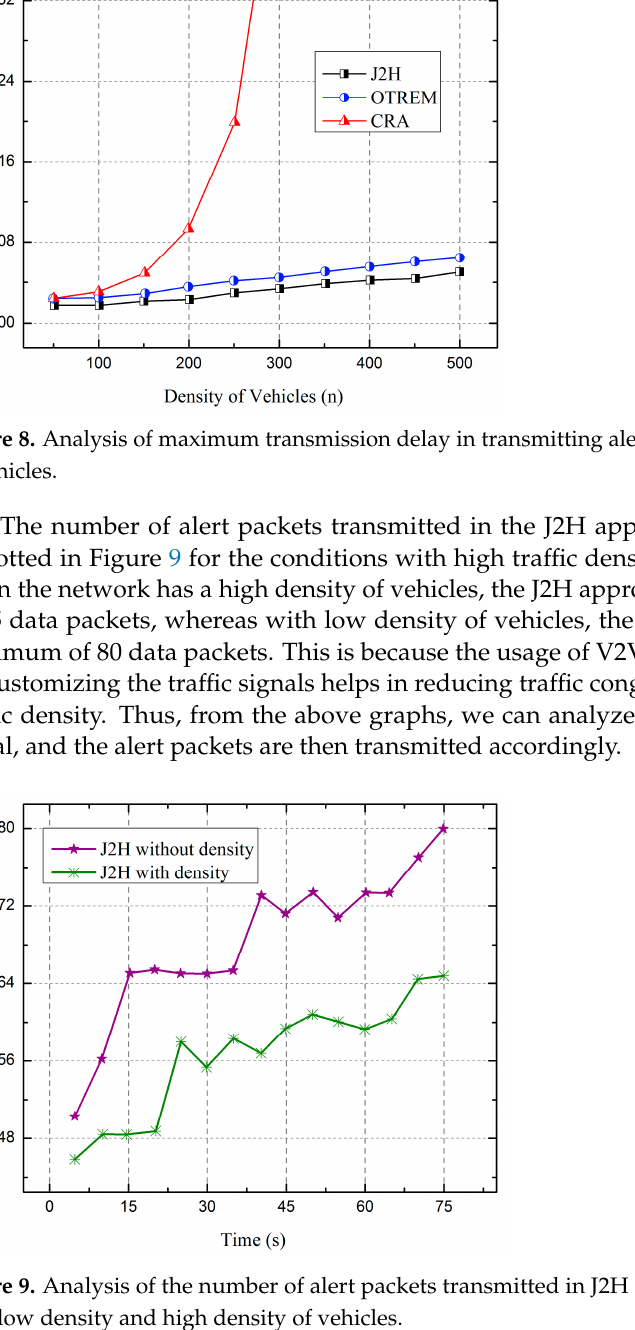
Figure 7. Analysis of maximum transmission delay in transmitting alert messages with low density of vehicles.